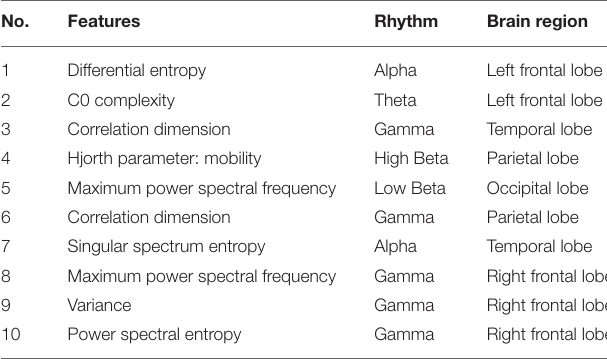
TABLE 3 | The features selected by the l 1 -regularized support vector machine under positive emotional stimulus. No. Features